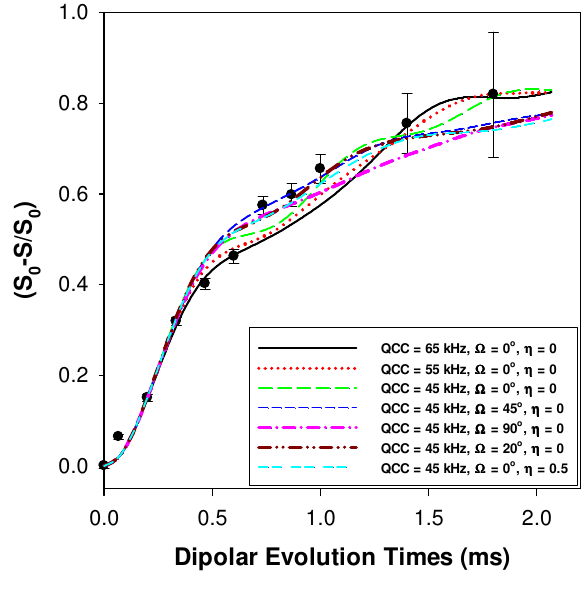
Figure 12. Predicted 1 H- 7 Li REDOR buildup curves as a function of the quadrupolar coupling constant (QCC) and the relative orientation of the EFG and 1 H- 7 Li dipolar tensors ( Ω ). The experimental REDOR response for the p9AA-43%Li ionomer is also shown ( ● ). The 1 H- 7 Li dipolar coupling constant was 1100 Hz for all